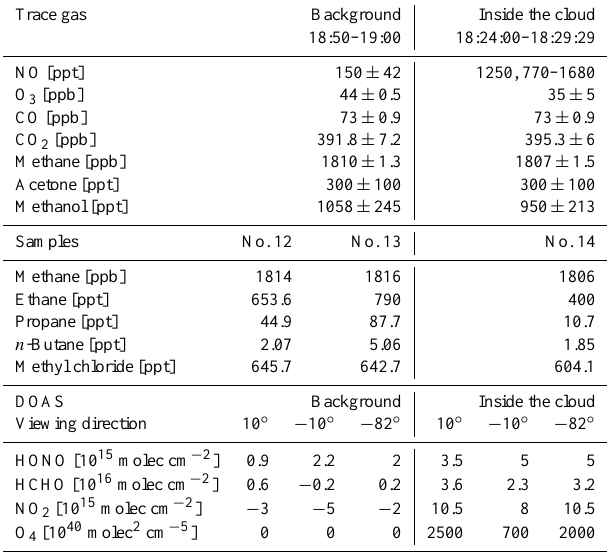
Table 3. Overview of several CARIBIC in situ measurements in- side (18:24:00–18:29:29UTC) and outside (18:50–19:00UTC) the cloud. Because the distribution of the NO values inside the cloud is far from Gaussian, we used the first, second and third quartile instead of the average and the standard deviation. The NO back- ground values were measured before entering the cloud, because for the period after the cloud there seems to be an enhancement due to lightning NO x advection. Air sample No. 14 was taken at 18:31:02UTC, which was close to the cloud edge. For comparison, the values of the two previous samples (No. 12 at 17:14:57UTC and No. 13 at 17:52:57UTC) are listed, as no sample was taken during the background period. Therefore, the in situ methane mea- surements cannot be expected to agree with the samples. Finally, the DOAS slant column densities used for further analysis are included. Here the data close to the maximum were averaged.